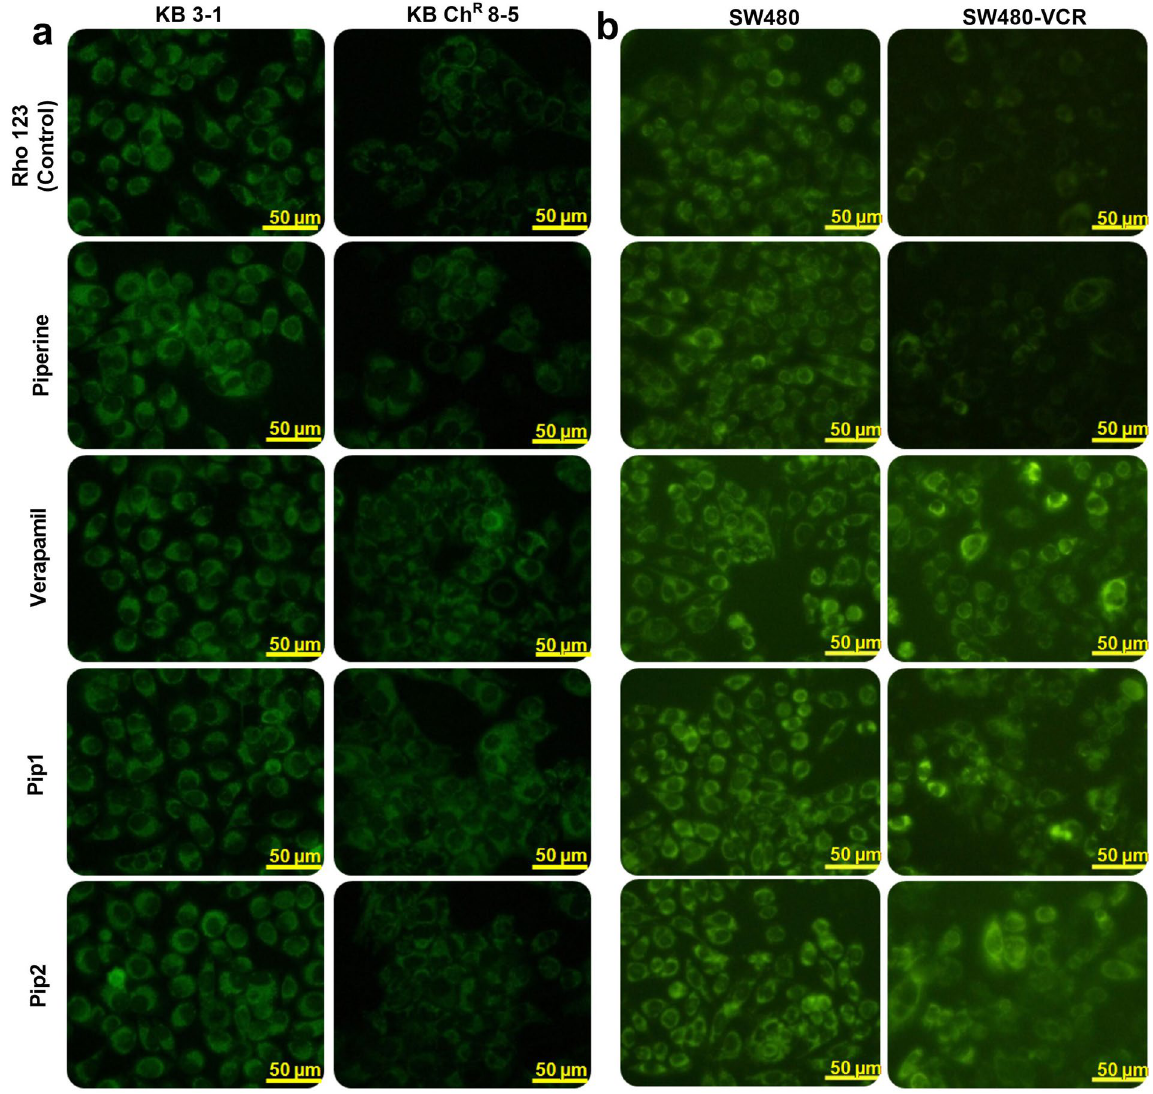
Figure 10. Effect of piperine analogs on Rho 123 accumulation in ( a ) KB 3–1 (parental) and KB Ch R 8–5 (resistant) cells and ( b ) SW480 (parental) and SW480-VCR (resistant) cells. Cells were incubated with 4 μ M of verapamil, piperine, Pip1, and Pip2. The compounds concentration in this assay was twice as that used for the cell viability and clonogenic assay, so as to clearly differentiate the Rho 123 accumulation between the control and treated cells. All the images were acquired using 20 × objective in a Nikon Eclipse Ti-S inverted fluorescence microscope (Scale 100 µ M) (Nikon Instruments, Melville, New York), and processed with Nikon Br 4.0